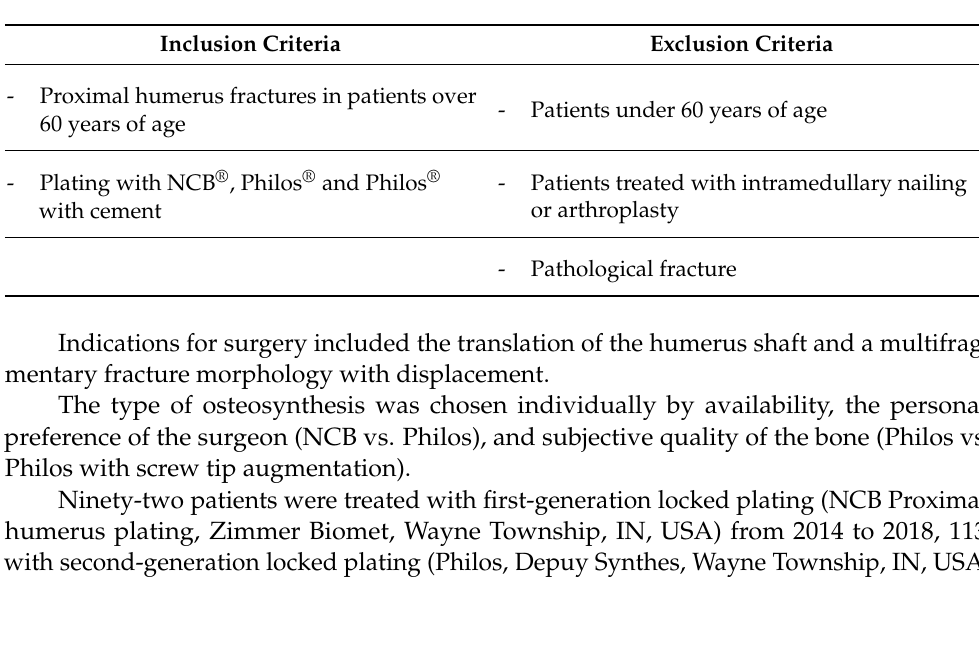
Table 1. Inclusion and exclusion